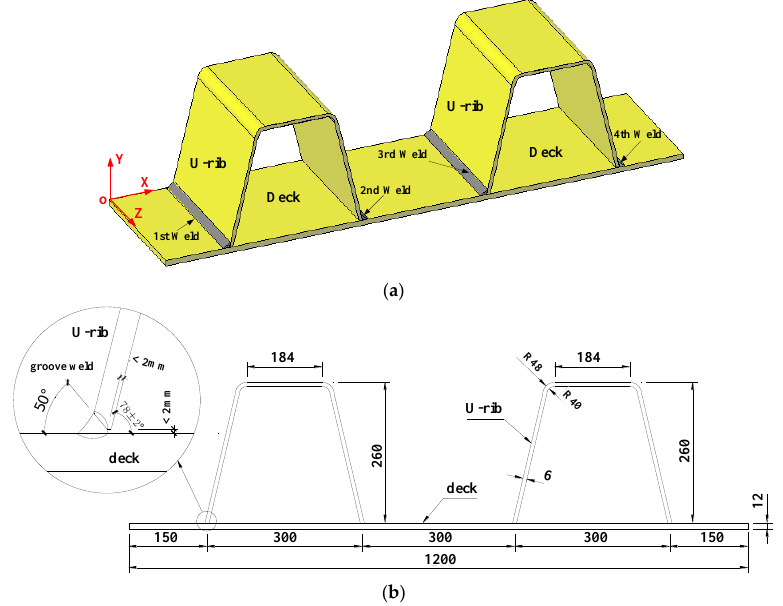
Figure 1. Orthotropic steel deck (OSD) experimental specimens: ( a ) space diagram and measurement paths; ( b ) cross section and dimensions (units: